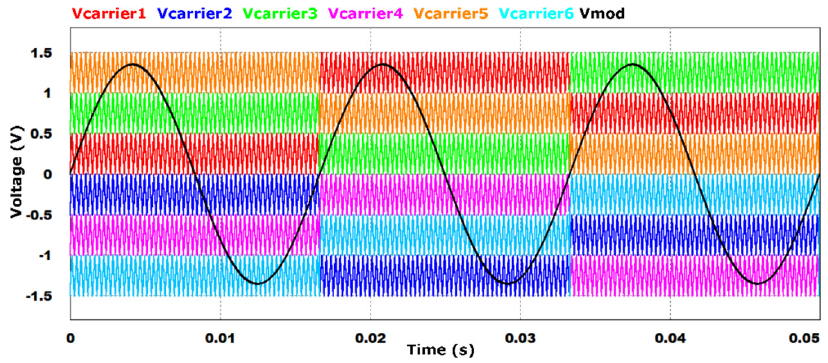
Figure 6. Carrier and modulator signals of the LS PWM modulation strategy, per the modulating signal